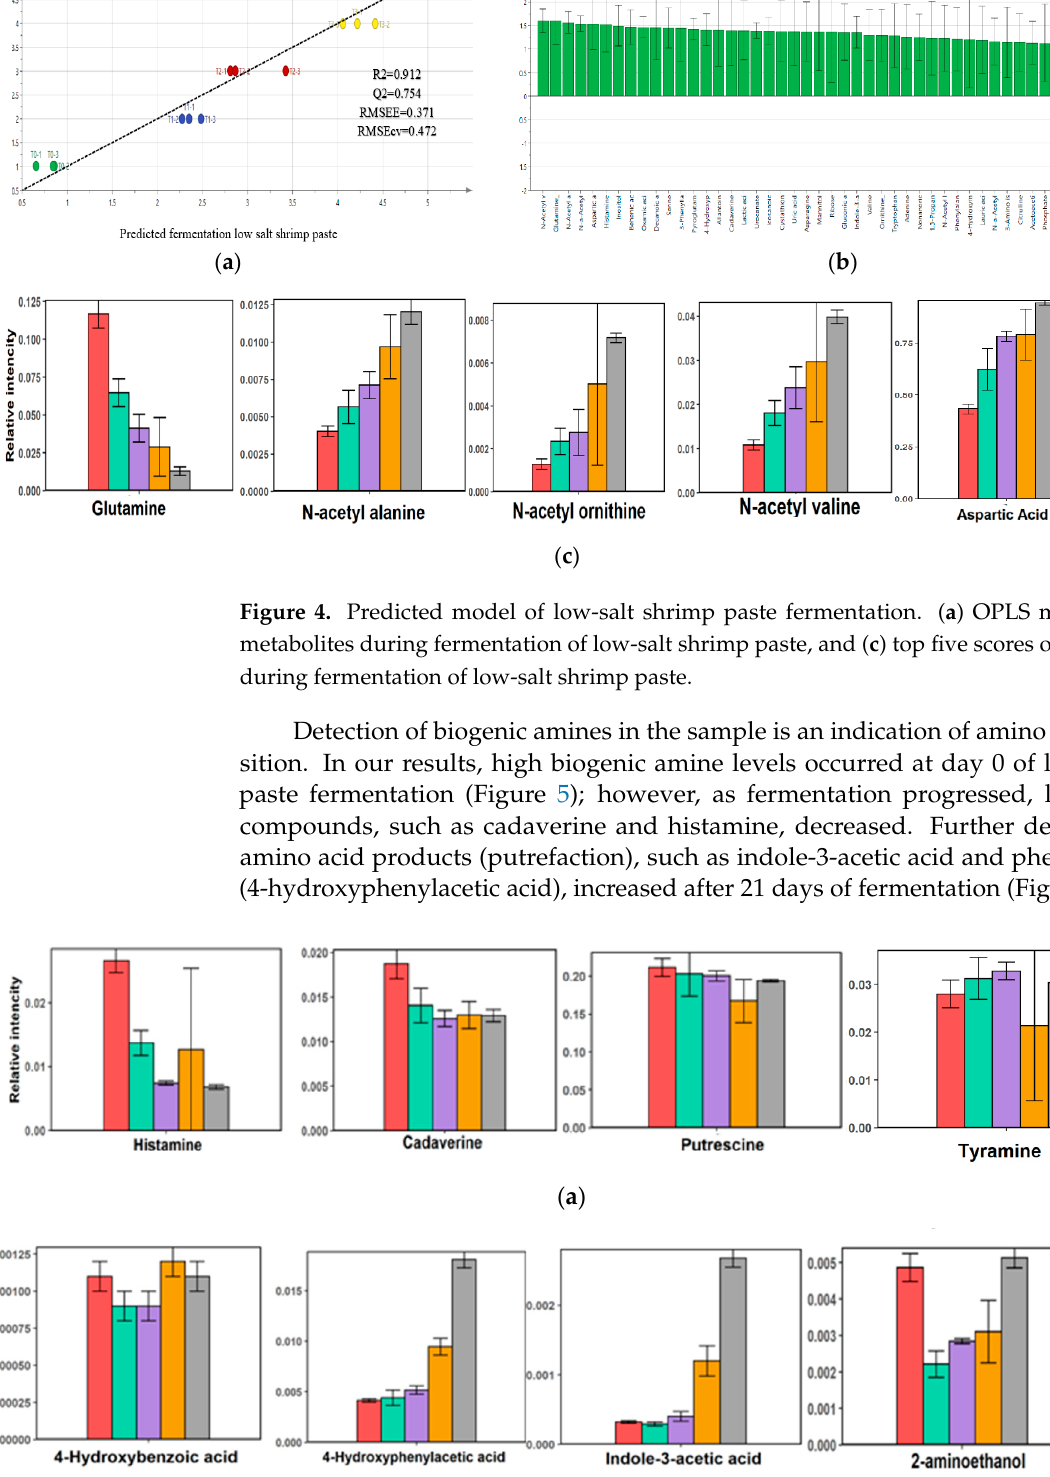
Figure 5. Biogenic amines production and decomposition of amino acids during fermentation of low-salt shrimp paste. ( a ) Biogenic amines; ( b ) decomposition of amino acids compounds during fermentation of low-salt shrimp paste.